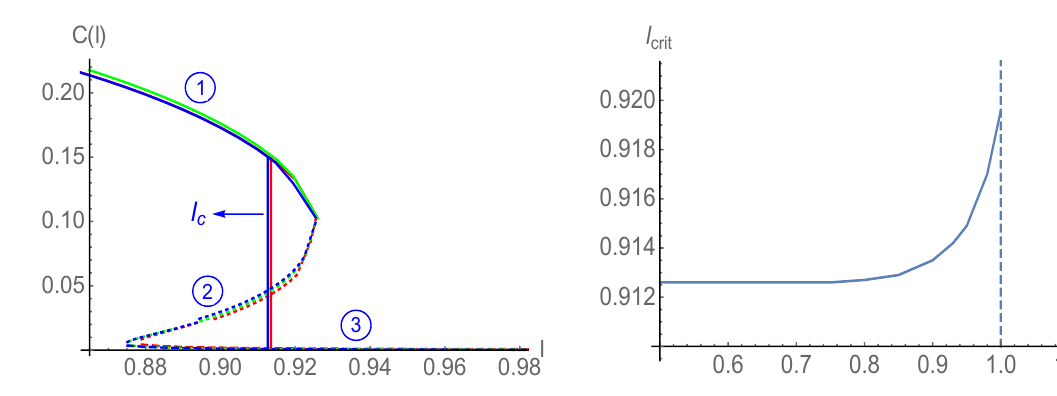
Figure 27 . The entropic C -function as a func- tion of ‘ in the specious-con(cid:12)ned phase. Here (cid:22) = 0 and red, green and blue curves correspond to T=T c = 0 : 9, 0 : 8 and 0 : 7 respectively. In units GeV.